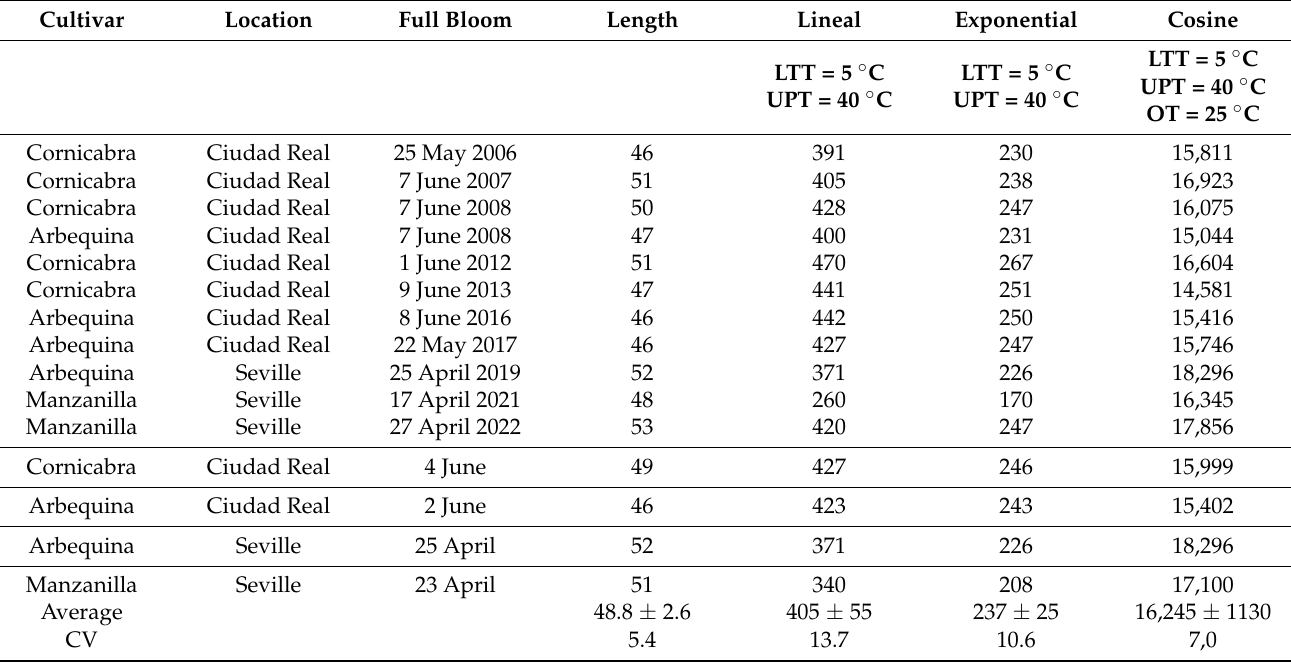
Table 2. Characterization of Period I of endocarp development in different cultivars and locations: beginning (full bloom date), length (days), and thermal time ( ◦ days) according to three different models (lineal, exponential and cosine).